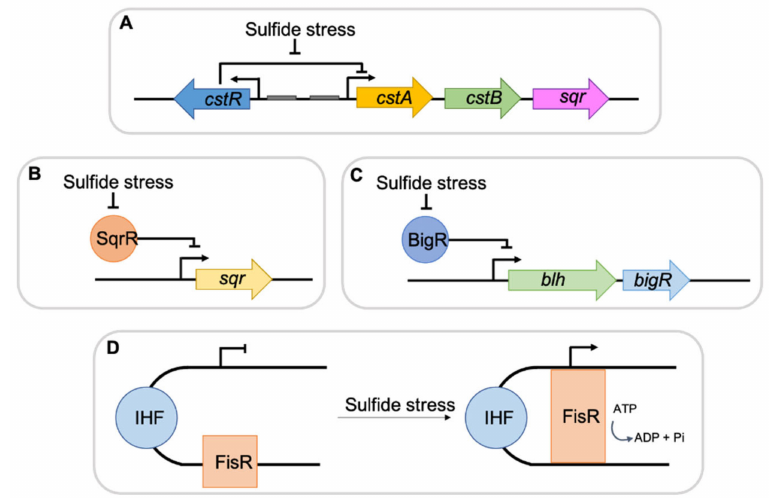
Figure 1. General scheme summarizing bacterial H 2 S regulators. ( A ) CstR regulator binds to the upstream region of the cst genes repressing their expression. During sulfide stress, the DNA-binding affinity of the repressor decreases allowing for RNA polymerase binding and gene transcription. ( B , C ) SqrR and BigR bind to promoter regions of sqr , blh and bigR genes, inhibiting transcription. In the presence of sulfide, the repression is lifted and genes expression occurs. ( D ) Under sulfide stress, FisR hydrolizes ATP to ADP plus free phosphate, resulting in RNA polymerase activation and increase in gene